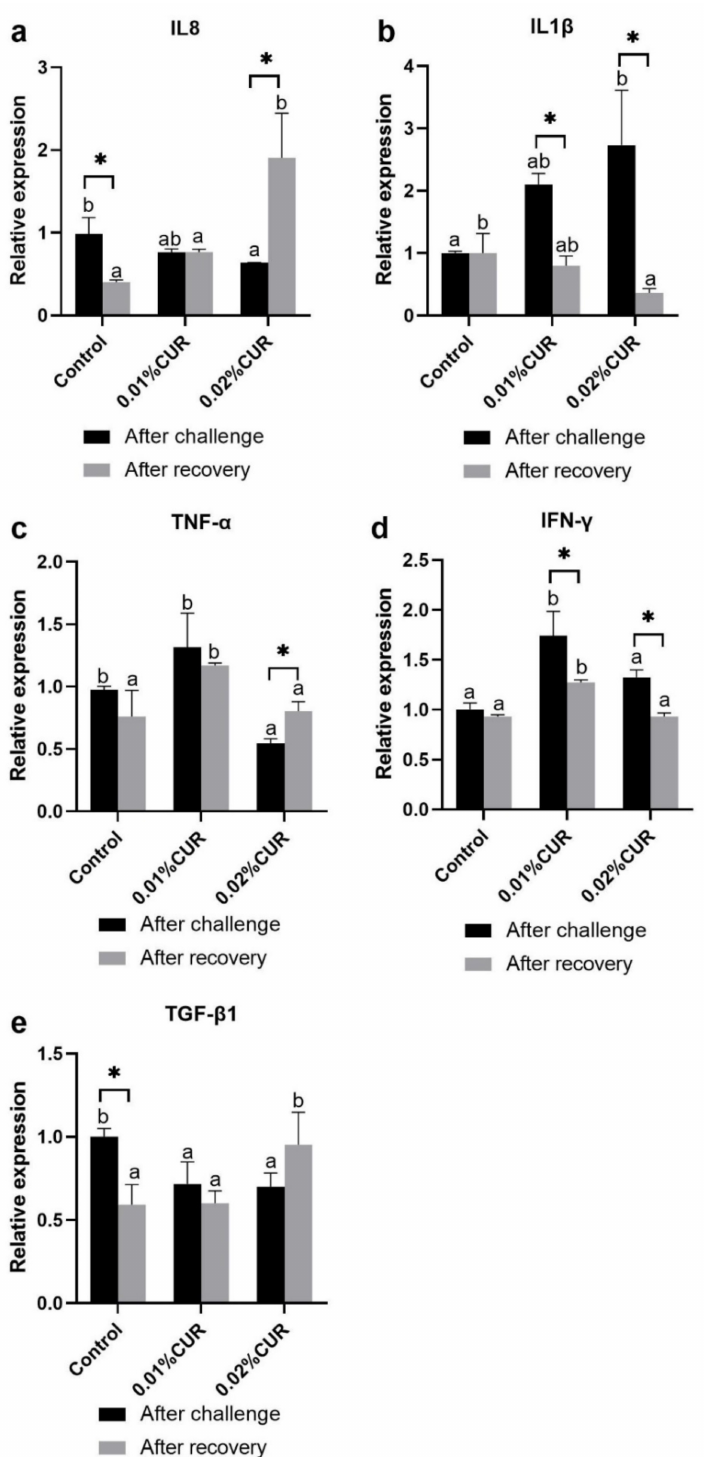
Figure 8. The relative expression of ( a ) cytokine IL8, ( b ) IL1 β , ( c ) TNF- α , ( d ) IFN- γ and ( e ) TGF- β 1 genes in intestine of greater amberjack fed with dietary curcumin supplementation. (Different letters above bars and asterisk sign (*) indicate significant differences at the 0.05